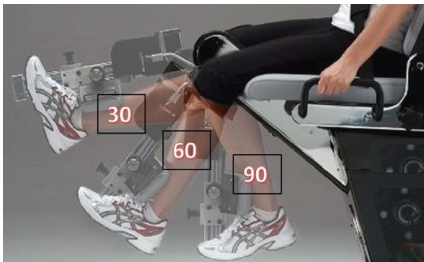
Figure 5: Maximum voluntary isometric contraction exercises at 30, 60, and 90 degrees of knee flexion